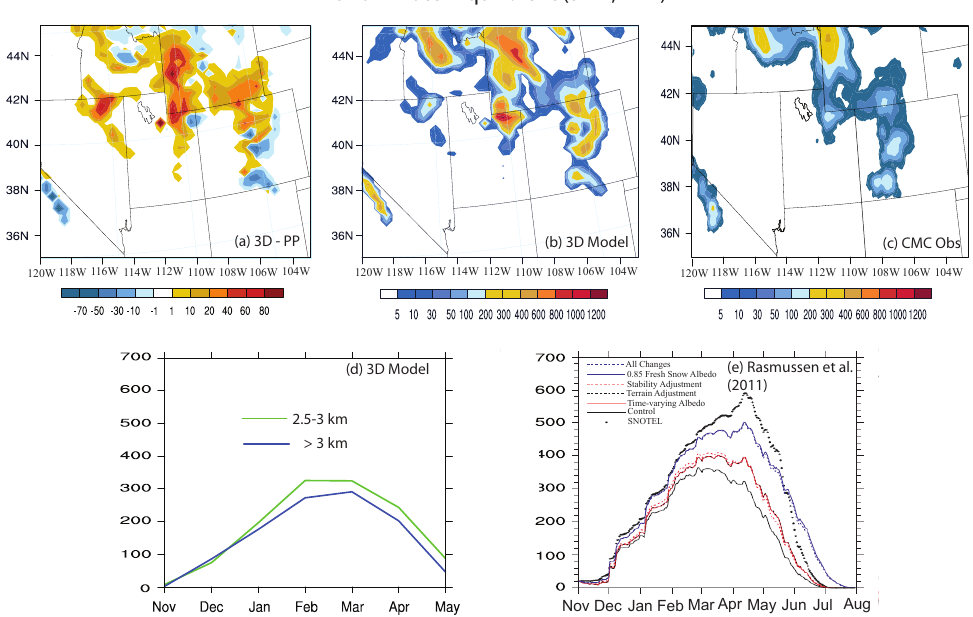
Snow Water Equivalent (SWE, mm)